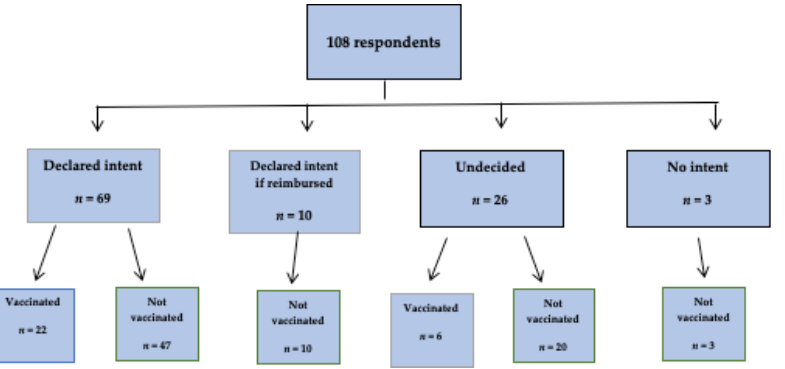
Figure 4. Influenza vaccination intent in the next season (2019/2020) by immunization receipt; Gryfino, Poland ( n = 108).